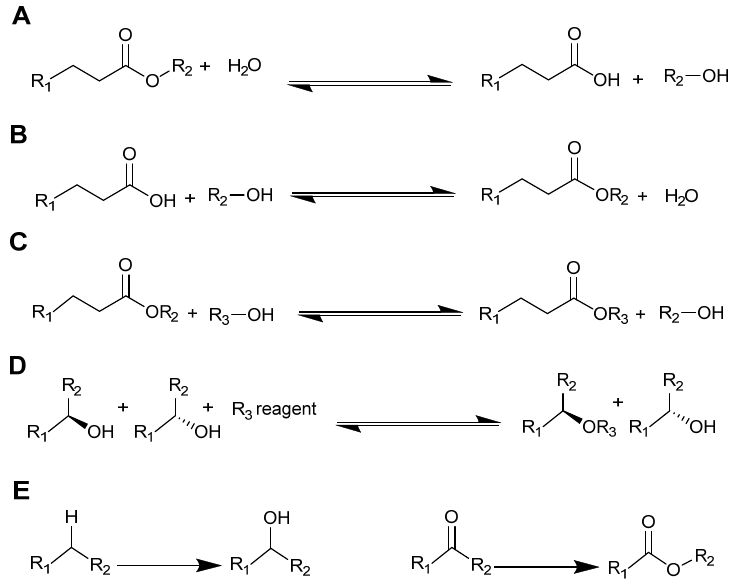
Figure 2. Reaction schemes of some common biocatalytic processes studied in ionic liquids. ( A ) Hy- drolysis, ( B ) esterification, ( C ) transesterification, ( D ) kinetic resolution, and ( E ) oxidation.